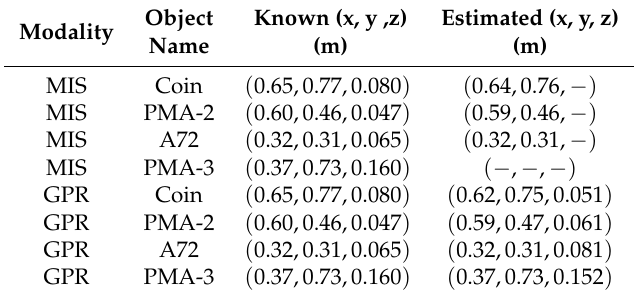
Table 4. Estimated positions of the objects in the